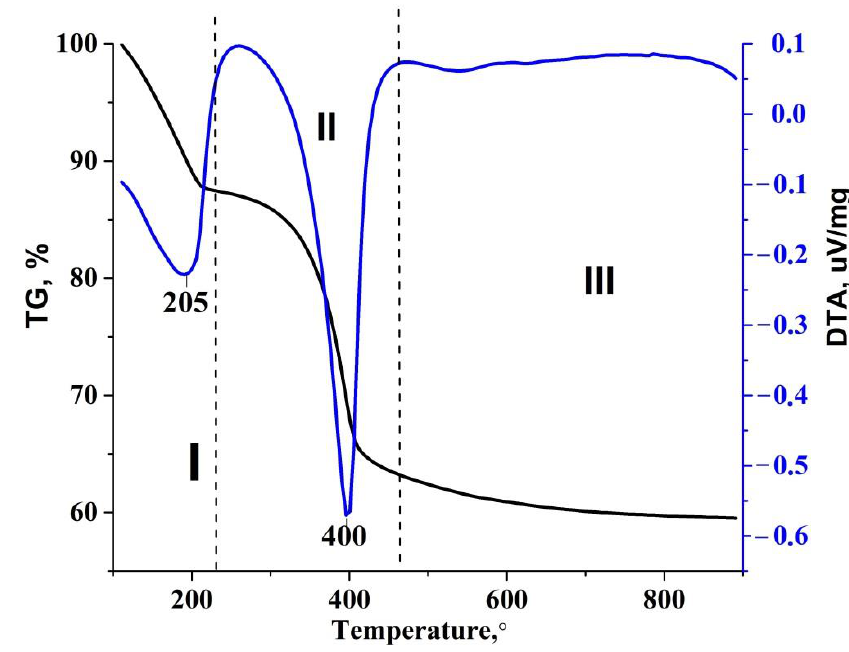
Figure 5. TG-DTA curves of Mg/AlNi-25-c.